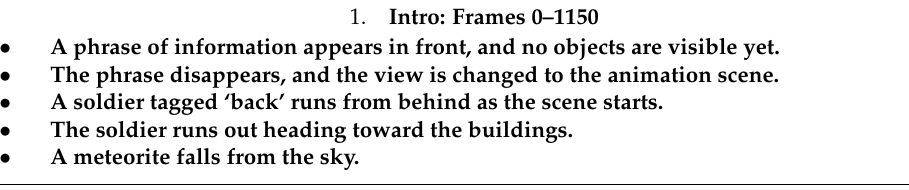
Table 1. An overall plot of the virtual reality (VR) story.